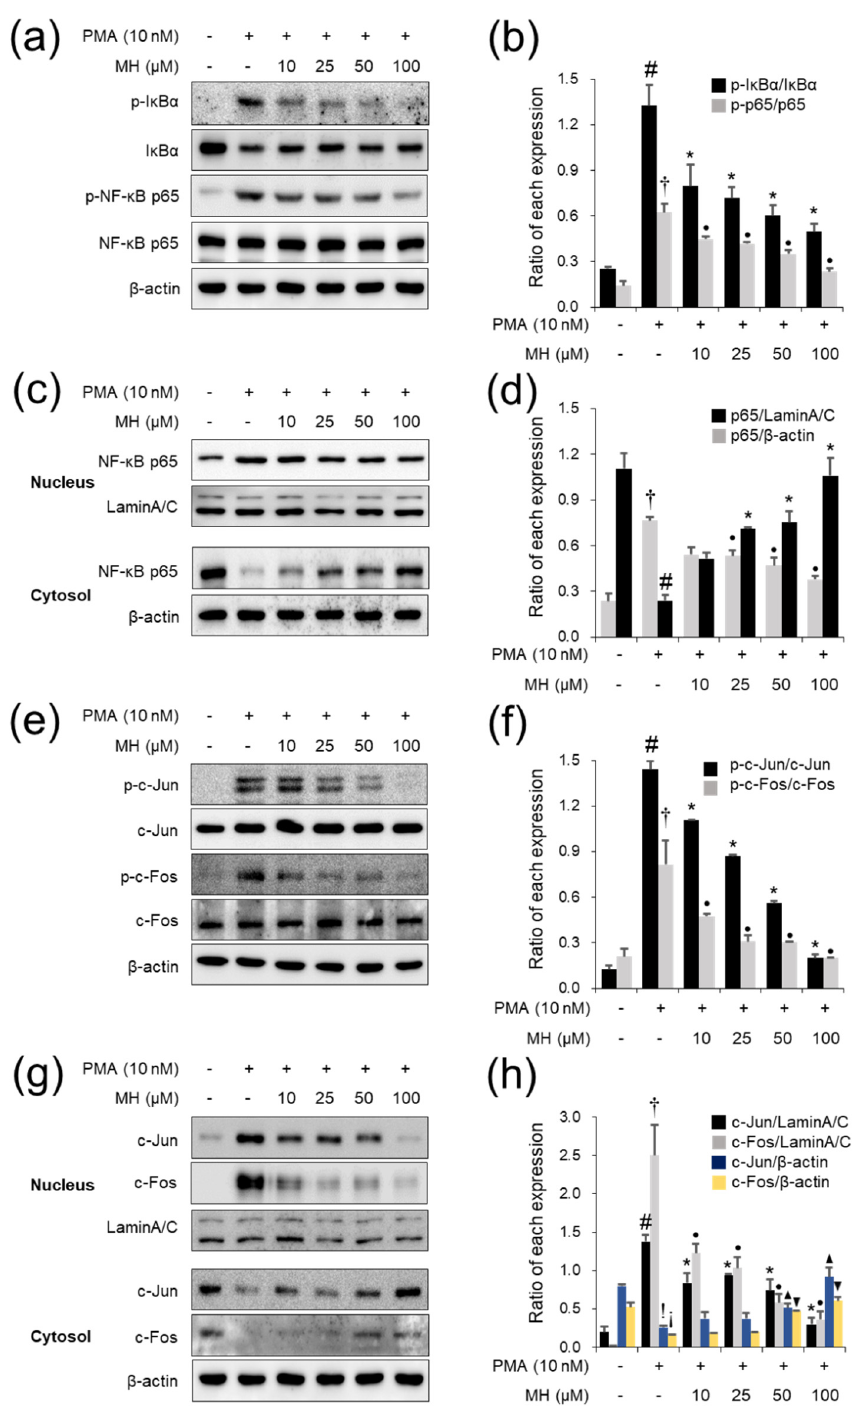
Figure 2. Effects of MH on activation of NF −κ B and AP − 1 in PMA − stimulated A549 cells. Cells were treated with MH (10, 25, 50, and 100 μ M) 1 h prior to incubation with 10 nM PMA for 1 h. ( a , b ) The levels of p − I κ B α and p − NF- κ B p65 in whole cell lysate were detected using Western blotting. ( c , d ) The levels of NF −κ B p65 in cytoplasmic cell fraction lysate and nuclear cell fraction lysate were detected using Western blotting. ( e , f ) The levels of p − c − Jun and p − c − Fos in whole cell lysate were detected using Western blotting. ( g , h ) The levels of c − Jun and c − Fos in cytoplasmic cell fraction lysate and nuclear cell fraction lysate were detected using Western blotting. Data are expressed as the mean ± SD (n = 3) ( #,†, !,¡ p < 0.05 for comparison with control; * , ● , ▲,▼ p < 0.05 for comparison with 10 nM PMA).